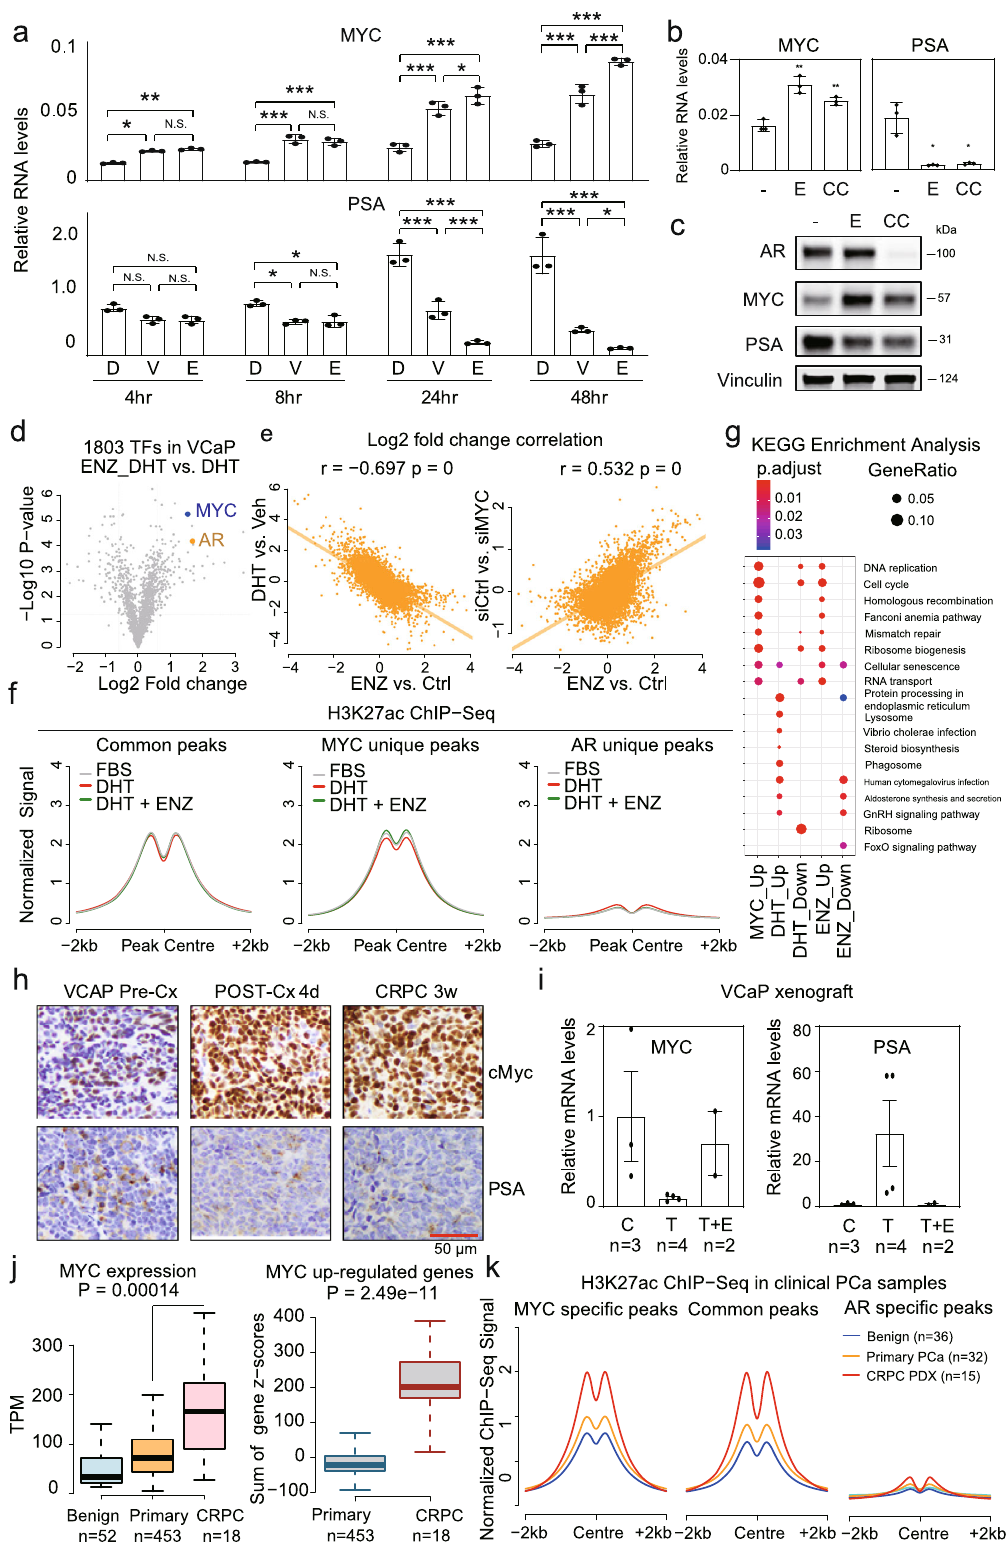
chromosome conformation capture (4C) to directly examine MYC promoter interactions (Fig. S8c). Consistent with the H3K27ac HiChIP, this showed MYC promoter interaction with multiple sites localized within the 8q24 TAD, including